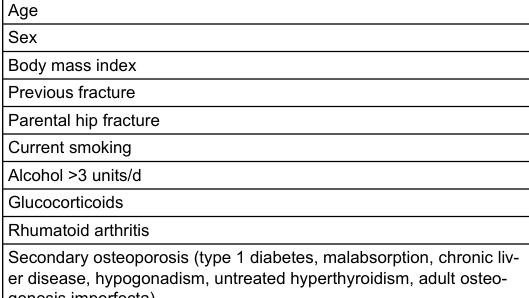
Table 1: Clinical risk factors for fractures in